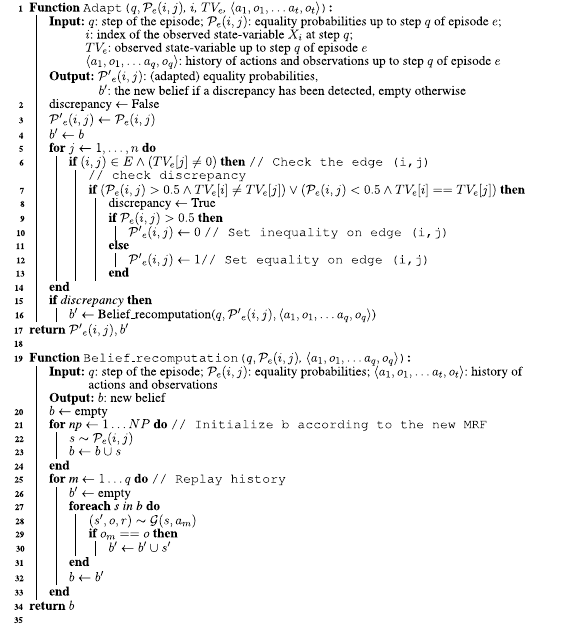
Algorithm 2. MRF adaptation